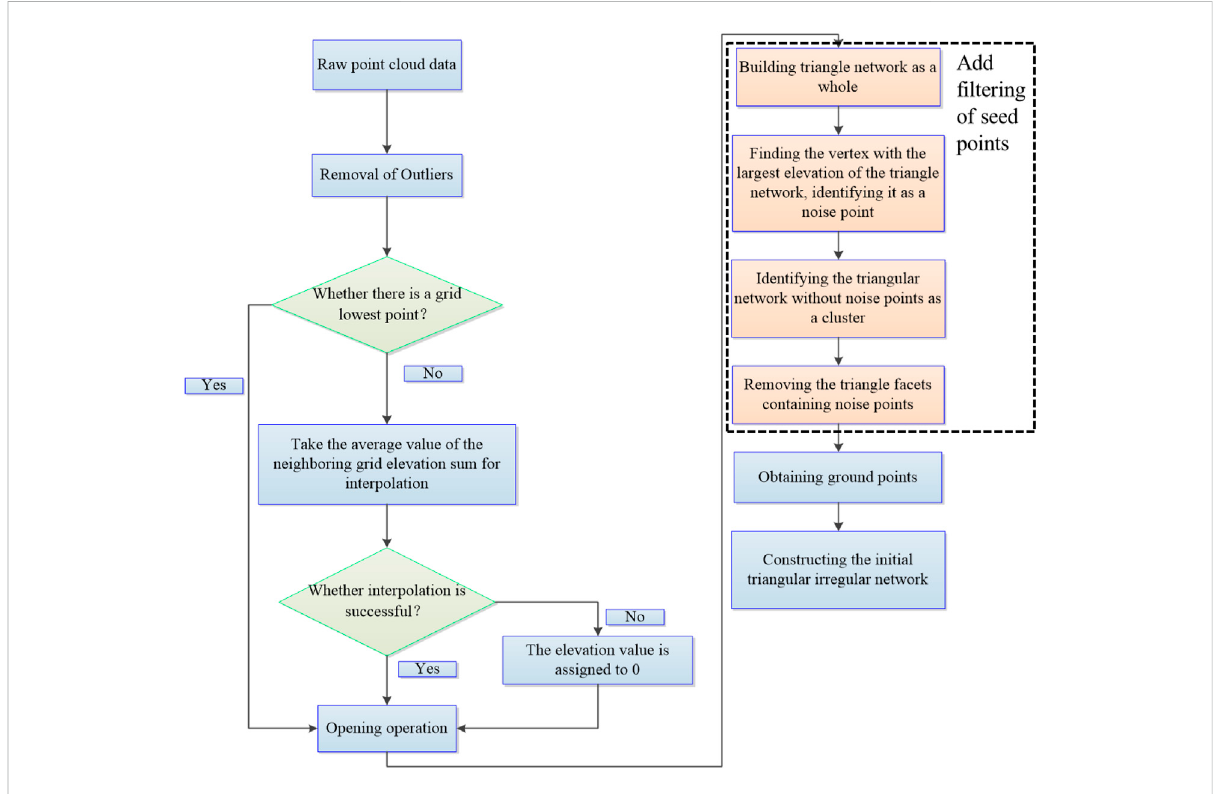
FIGURE 1 Flow chart of the improved fi ltering algorithm in this paper.